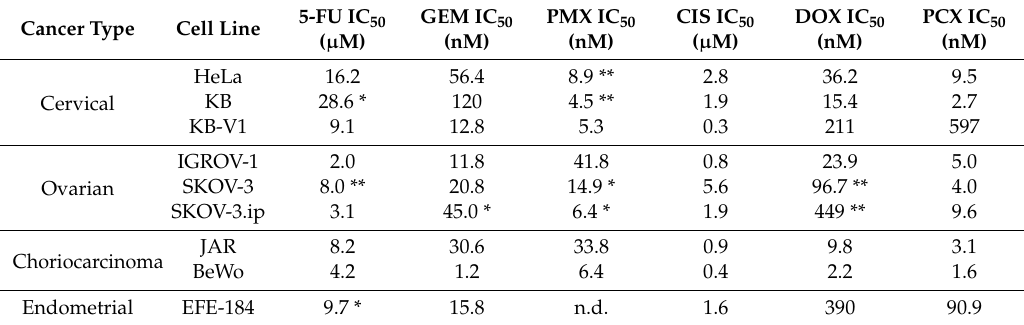
Table 1. IC 50 values of cells treated with 5-fluorouracil (5-FU), gemcitabine (GEM), pemetrexed (PMX), cisplatin (CIS), doxorubicin (DOX) and paclitaxel